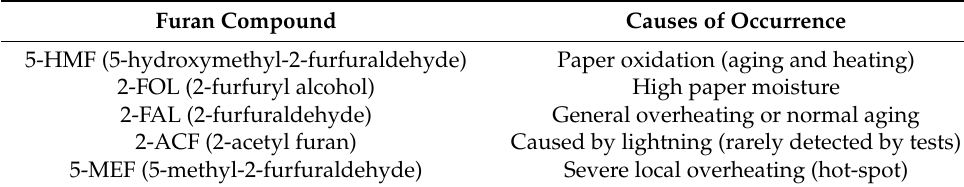
Table 9. Possible causes of the specific presence of the furan